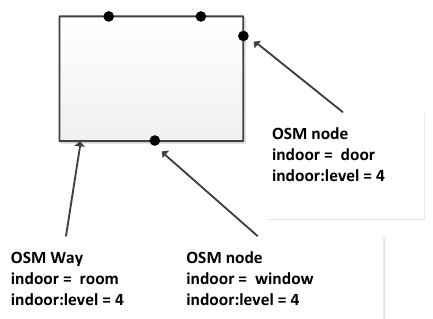
Figure 2. Modeling of a room with windows and doors.